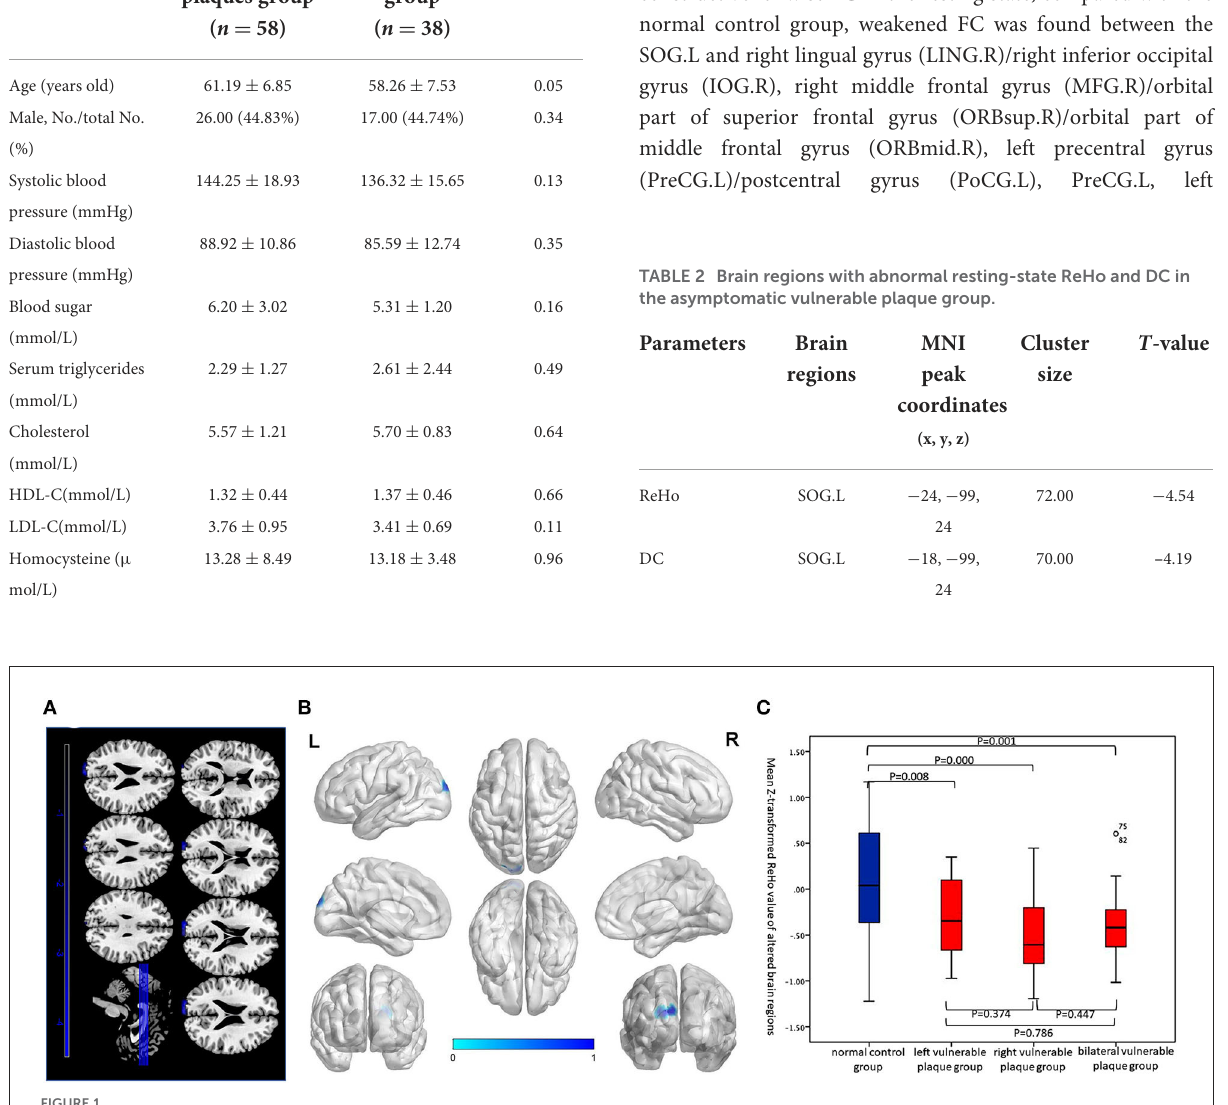
TABLE 2 Brain regions with abnormal resting-state ReHo and DC in the asymptomatic vulnerable plaque group.